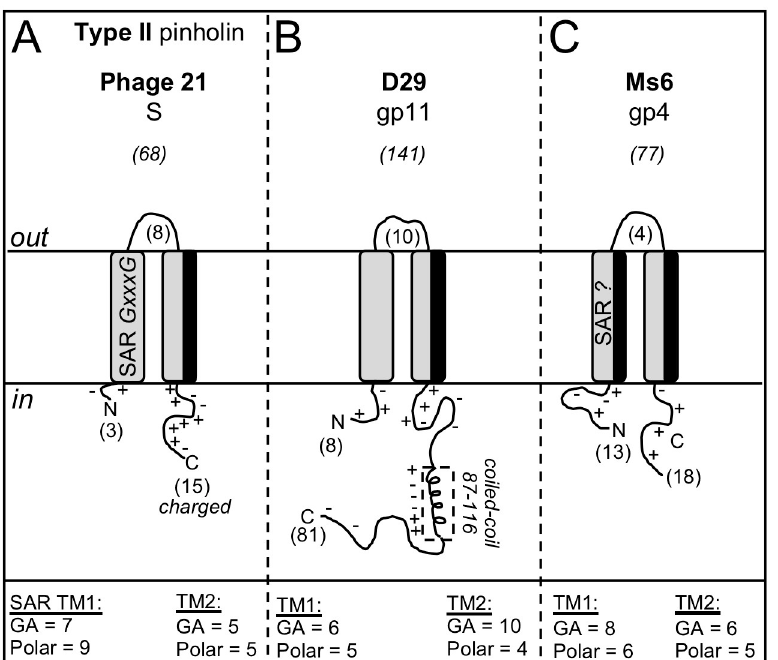
Fig 3. Validated holins with 2 TM helices. TM helices are indicated by the gray areas spanning the membrane. TM helices with dark shading to one side indicate a hydrophilic face. Coiled-coil regions are shown as helix within a dashed box. Amino acid characteristics of TM1 and TM2 are shown in the bottom panel: GA = number of glycine and alanine residues in the helix; Polar = number of polar residues in the helix (STYQNDEKHR). N = N-terminal; C = C- terminal;+ = location of a positive residue (RKH);— = location of a negative residue (DE); numbers in parenthesis indicate the number of amino acids in a given domain or the size of the reference protein above the phage name. SAR = Signal arrest release sequence. GxxxG = the presence of a GxxxG region in the TM helix.